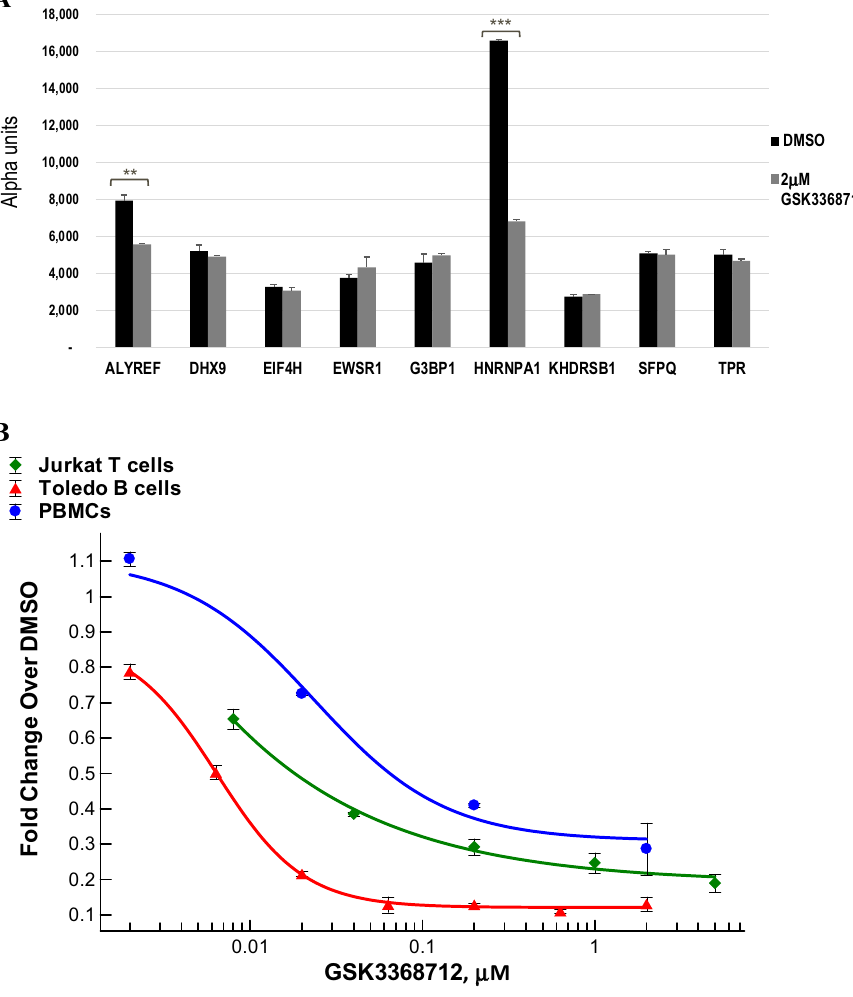
Figure 3. Reduction of ADMA on hnRNP-A1 across normal PBMCs and cancer cells. ( A ) AlphaLISA for candidate substrates identified in the MethylScan study using lysates from TCR-activated human PBMCs treated with either DMSO or 2 µM GSK3368712 for 72 h (two-tailed Student’s t test: ** p < 0.01, *** p < 0.001; p-values not indicated if no statistically-significant difference was observed). ( B ) ADMA-hnRNP-A1 levels in lysates from non stimulated PBMCs and cancer cell lines, Jurkat and Toledo, treated with increasing concentrations of GSK3368712 for 72 and 48 h, respectively. Data are expressed as the mean ± standard deviation